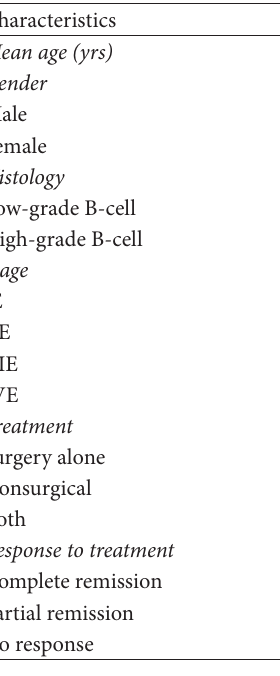
Table 1: Clinicopathological features and sites of origin of tumours investigated.